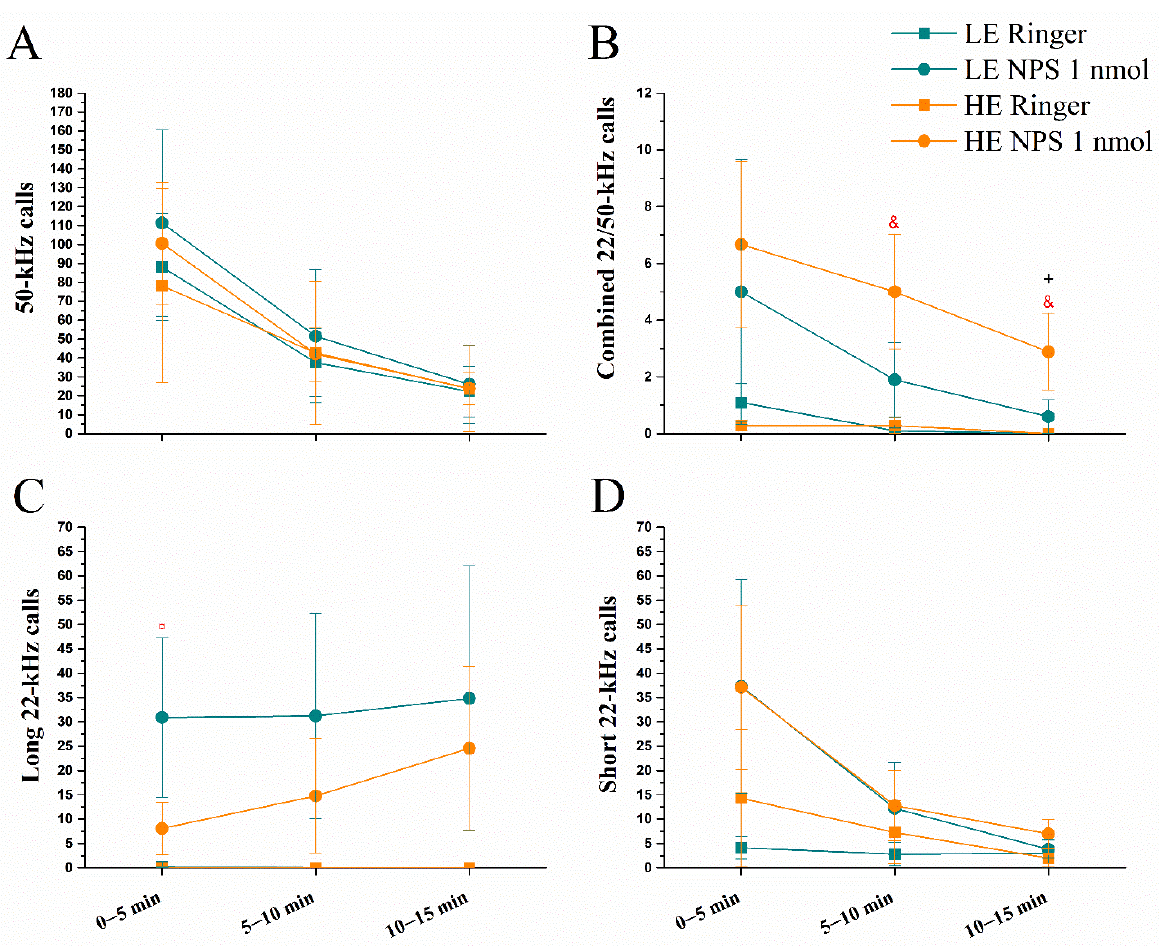
Figure 10. Number of ultrasonic vocalizations emitted in a novel large animal cage approximately 1 h after vehicle /NPS (1 nmol, i.c.v.) administration: 50 kHz ( A ), combined 22/50 kHz ( B ), long 22 kHz ( C ) and short 22 kHz ( D ) calls (data shown as mean ± SEM). &: p < 0.05 vs. HE vehicle; ¤: p < 0.05 vs. LE vehicle; +: p < 0.05 LE NPS. Red colour denotes difference from respective vehicle group. HE: high exploring rats; LE: low exploring rats; NPS: neuropeptide S. HE vehicle ( n = 7); HE NPS ( n = 9); LE vehicle ( n = 10); LE NPS ( n = 10).